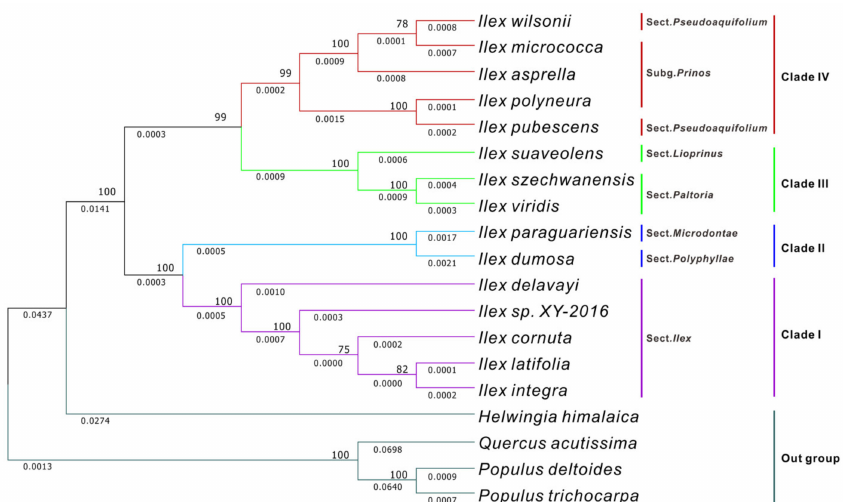
Figure 6. The phylogenetic analyses of 15 Ilex species using the entire plastid genomes. The evolutionary tree was constructed using MEGA X with the maximum likelihood (ML) method and the Tamura-Neighbour model. The percentage of trees in which the associated taxa clustered together is shown next to the branches. This analyses involved 19 plastid entire plastomes of I. latifolia